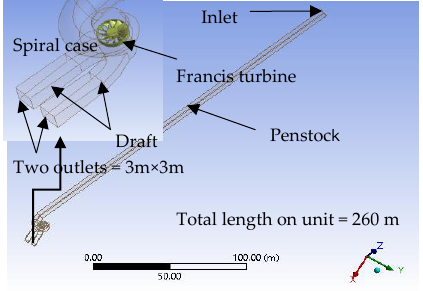
Figure 4. 3D model of vertical Francis unit with dimensions.